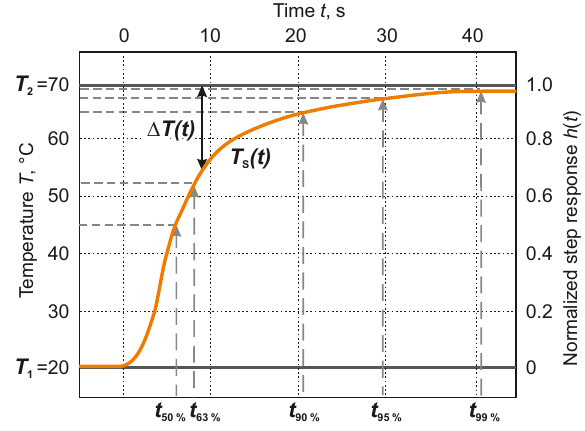
Figure 2. Representation of a temperature step when the medium is